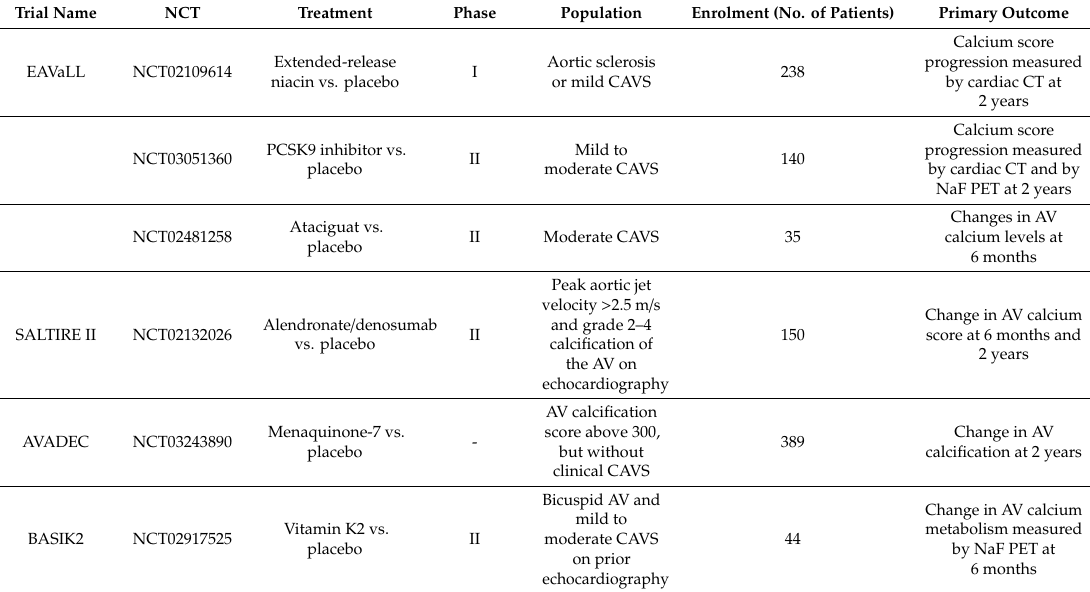
Table 1. Ongoing clinical trials involving patients with calcific aortic valve stenosis